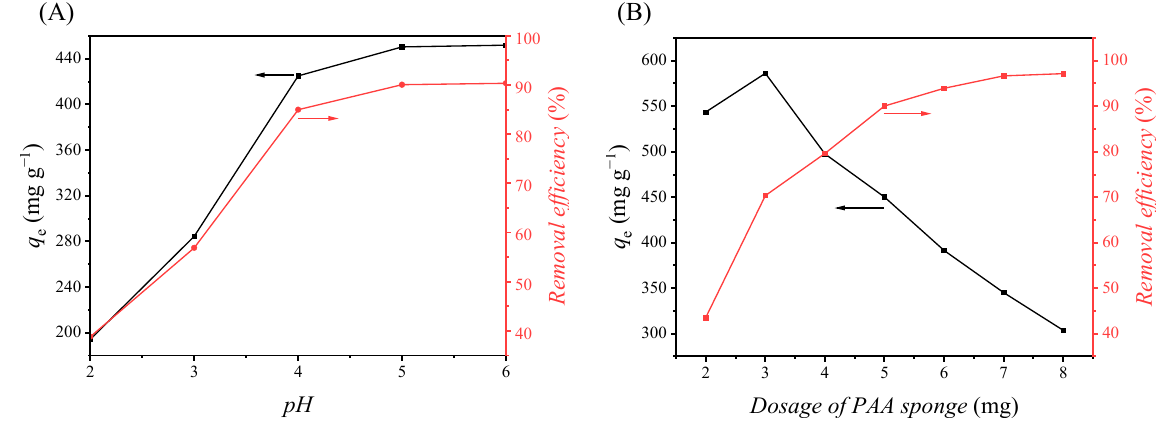
Figure 2. Effect of ( A ) pH and ( B ) dosage on the adsorption capacity at equilibrium ( q e ) and removal efficiency of the PAA sponge toward Pb(II).